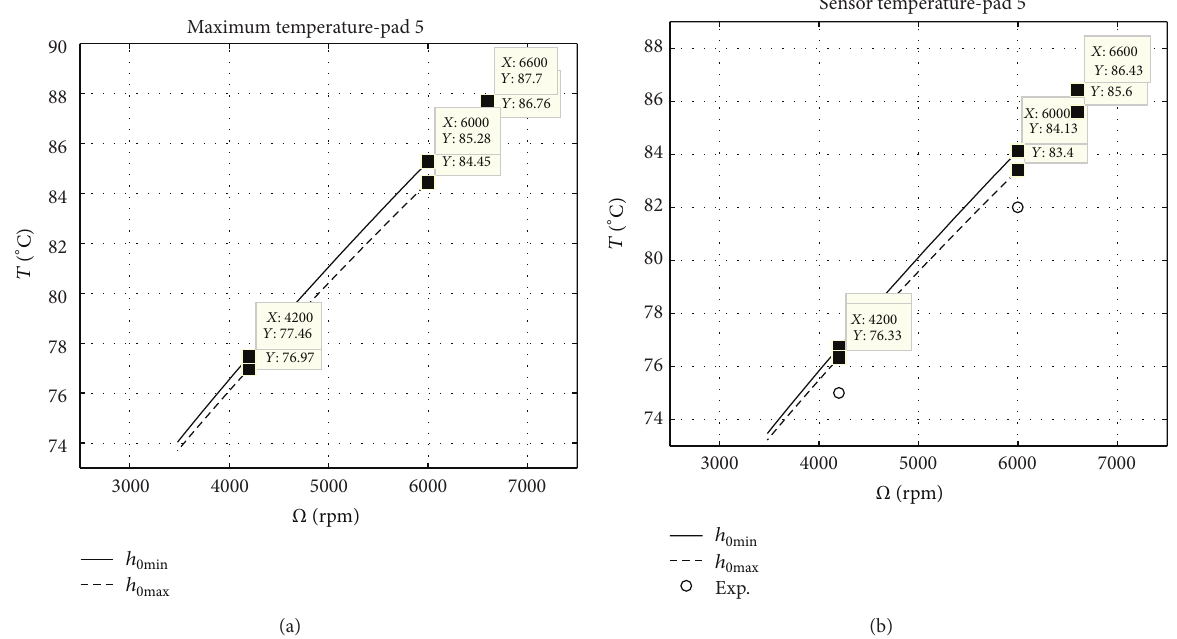
Figure 16: Temperature values obtained on pad 5: (a) maximum temperature; (b) temperature obtained in the sensor